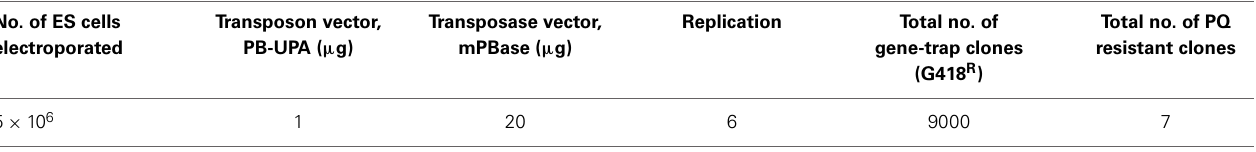
Table 1 | Generation of gene-trap library in C9 ES cells and the recovery of PQ resistant clones. No. of ES